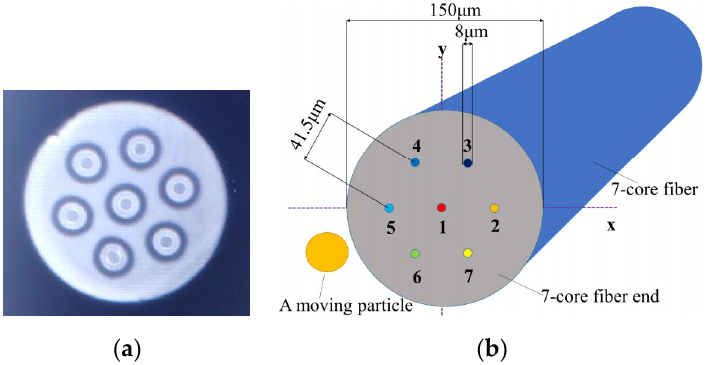
Figure 2. ( a ) Photo of multicore fiber (MCF) cross-section; ( b ) schematic structure of 7-core fiber probe with a moving particle.